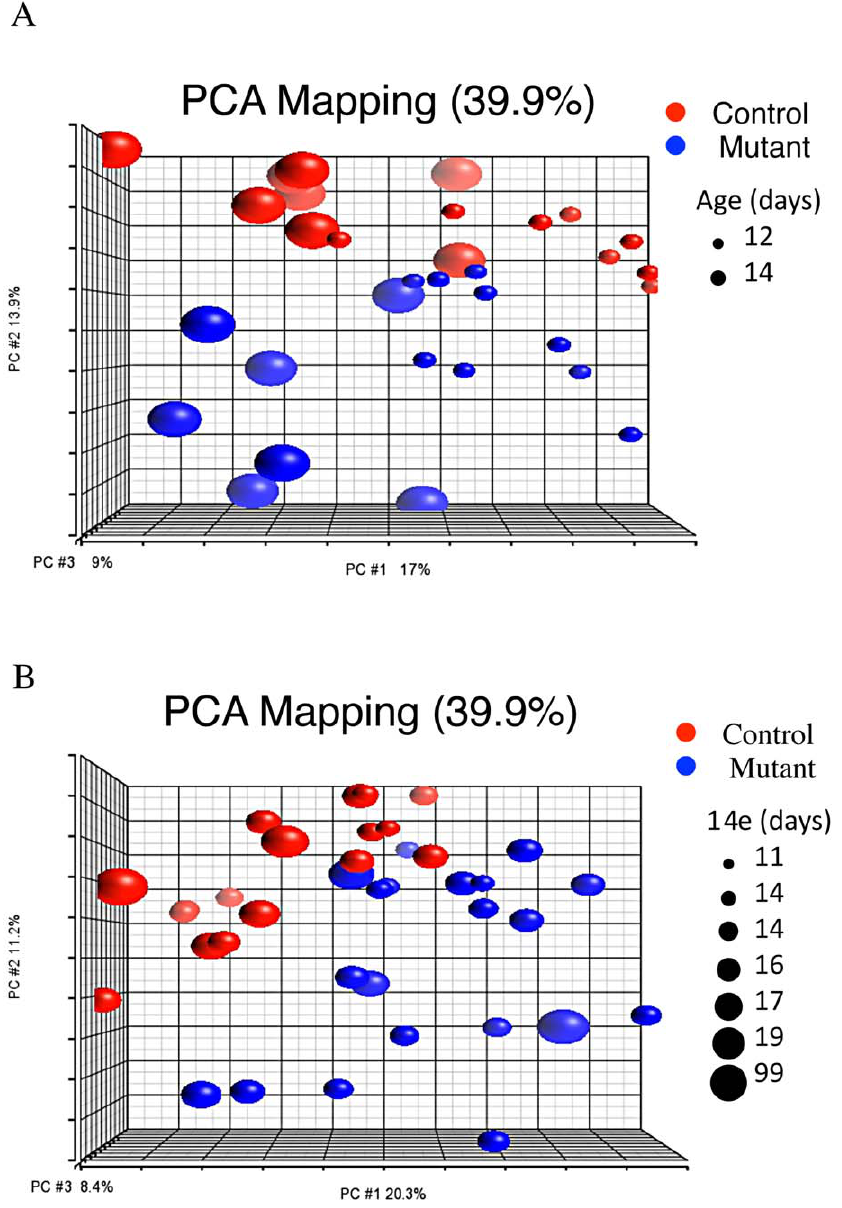
Figure 4. Meta-analysis of 1,114 gene expression arrays identifies gene clusters differentially expressed in Pkd1 mutant kidneys. PCA plot showing that module 17 separates mutant and control groups along the second principal component in both test (A) and validation (B) groups (meta-analysis genes in Table S9).